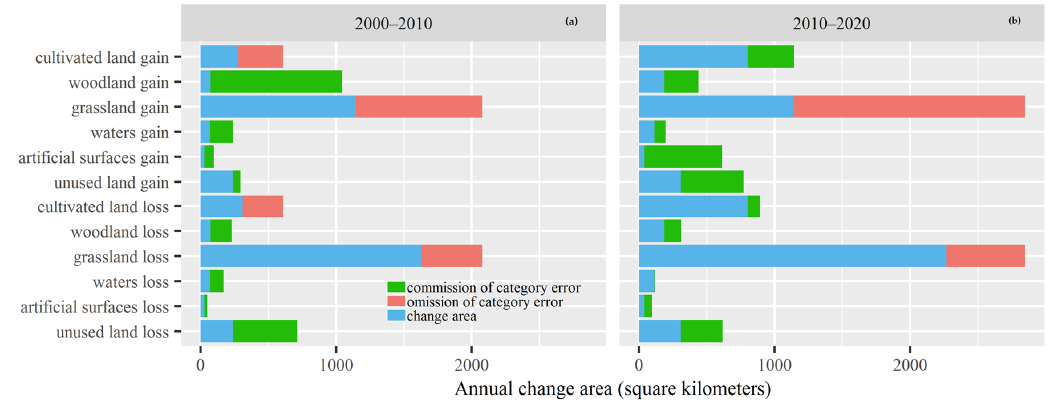
Figure 5. Category level change sizes along with hypothetical errors for the upper reaches of the YRB. ( a ) 2000–2010; ( b ) 2010–2020.